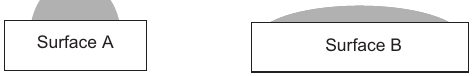
= 60 ° ) and hydrophobic Y